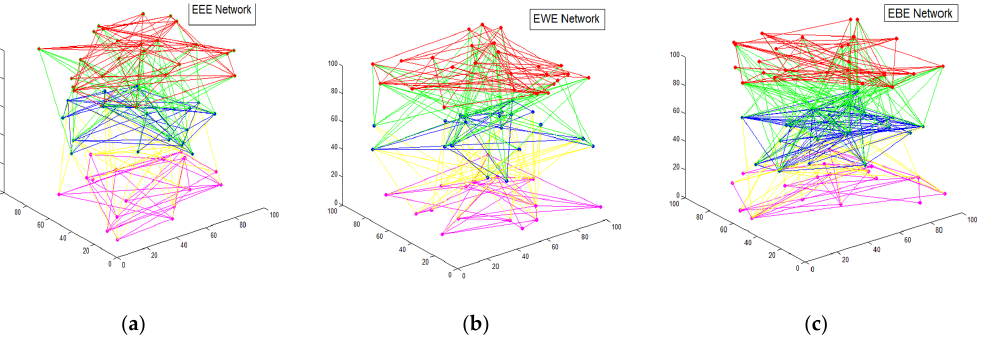
Figure 1. Three-layer network. ( a ) Three-layer network EEE; ( b ) three-layer network EWE; ( c ) three-layer network EBE.